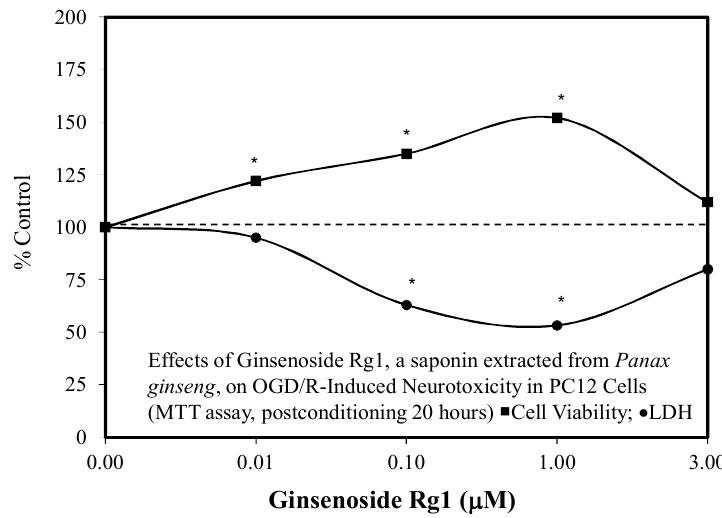
Figure 8. Effects of ginsenoside Rg1, a saponin extracted from Panax ginseng , on oxygen glucose deprivation(OGD)/reperfusion (R)-induced neurotoxicity in PC12 cells (MTT assay, postconditioning 20 h) (Source: [51]). Each * represent statistical significance for a data point.